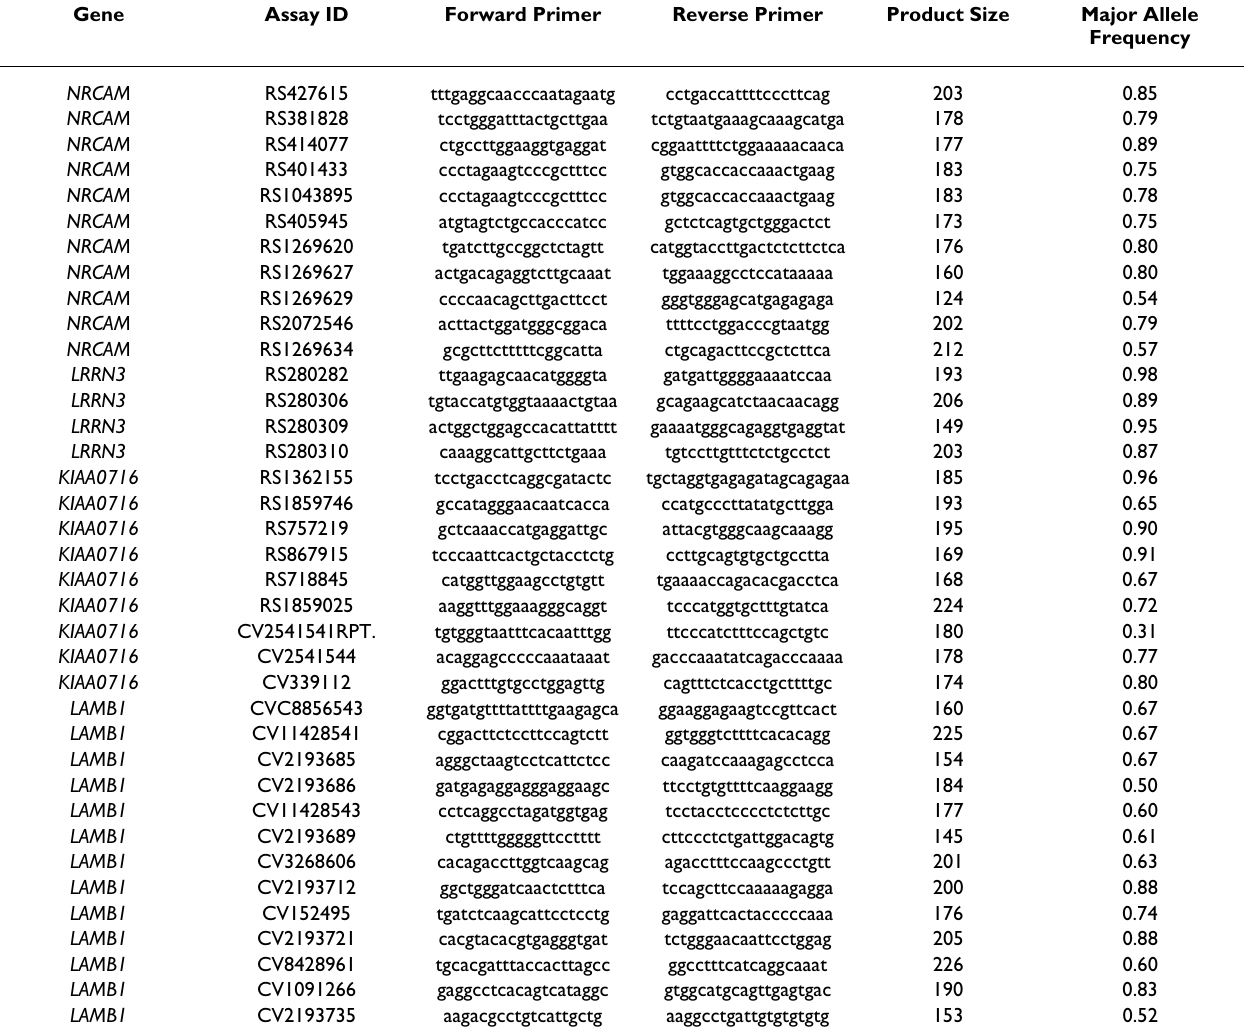
Table 1: Primers used for candidate geneSNP assays.